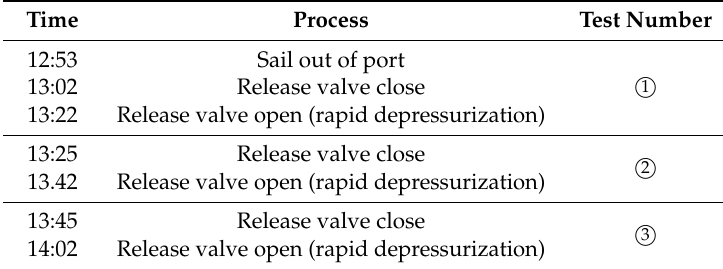
Figure 7. Track chart of the Fukae-maru inside Osaka Bay. Table 1. Time chart of experimental processes conducted inside Osaka Bay.